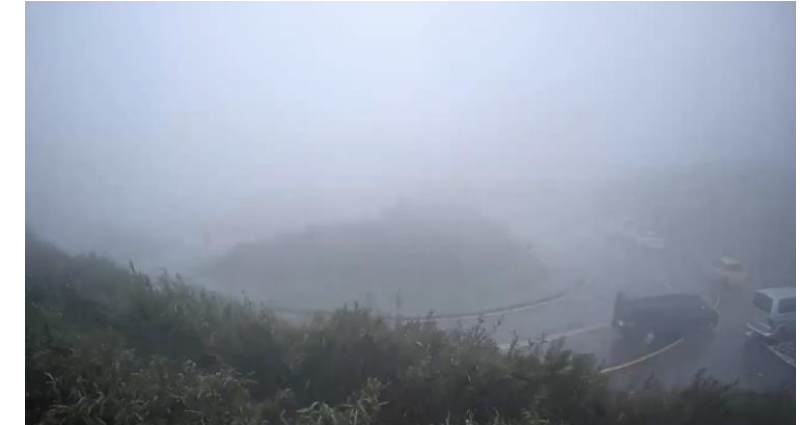
Figure 18. Haze scene: original image.